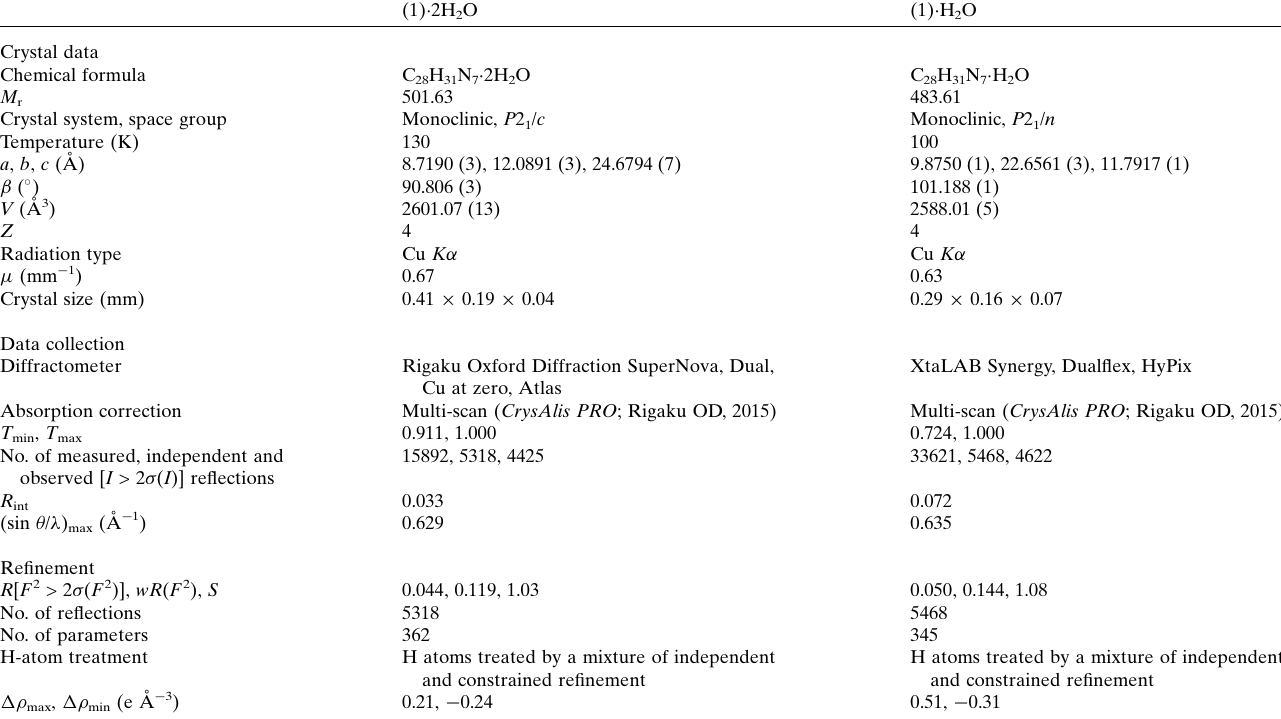
Table 5 Experimental